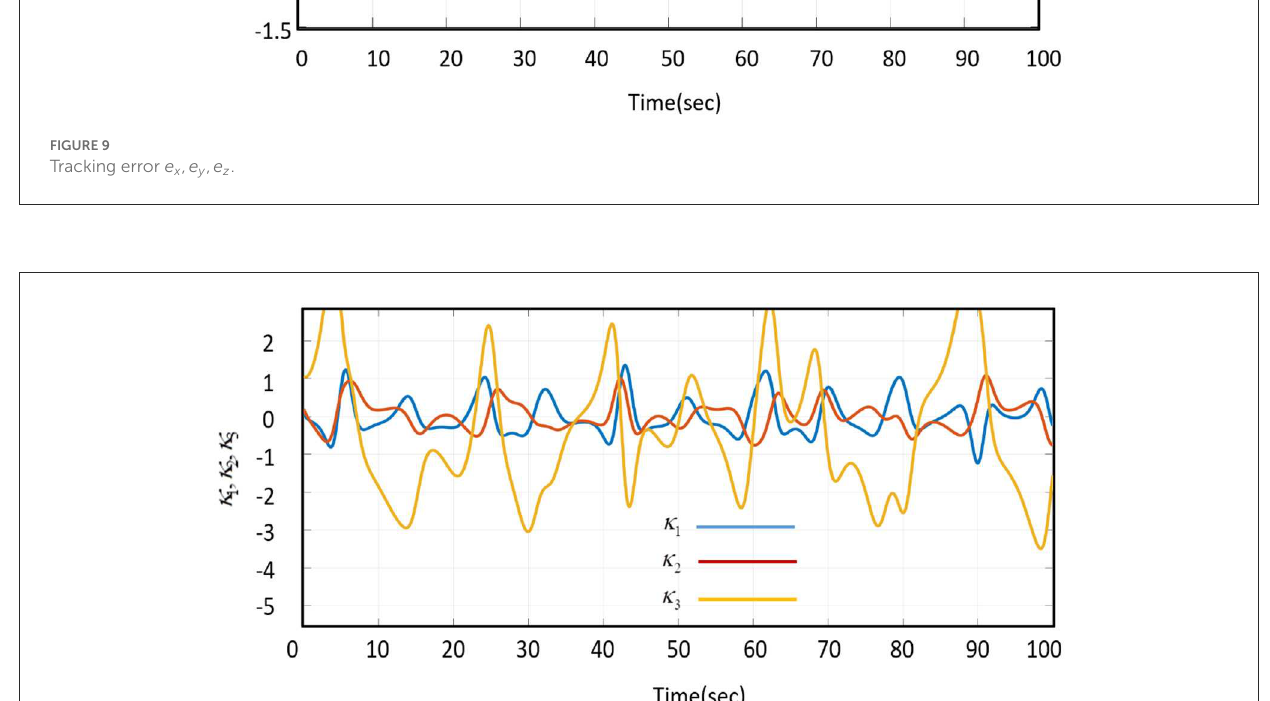
FIGURE10 The error model with a virtual variable for backstepping without activated control.